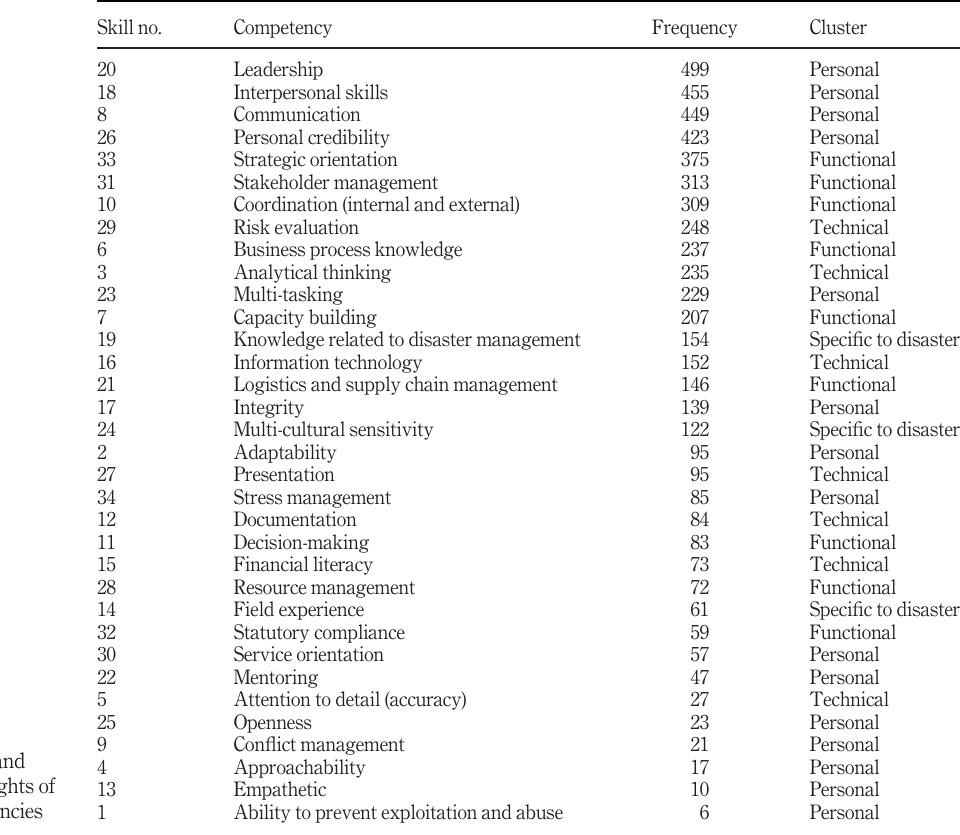
Table 3. Frequency and relative weights of the